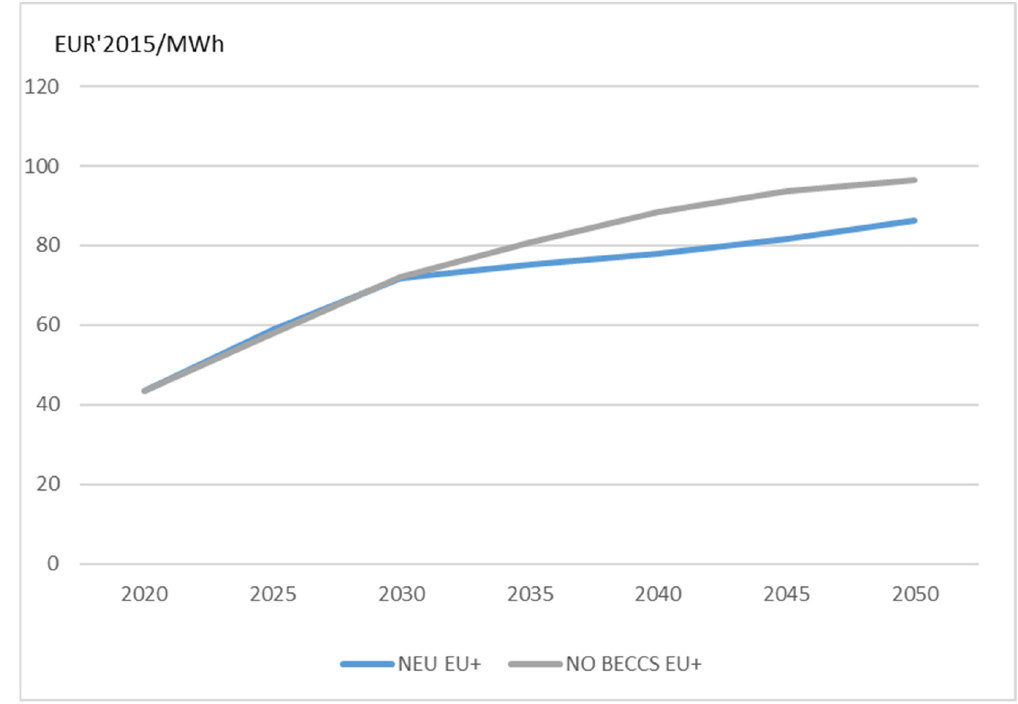
Figure 8. Average electricity generation cost in the EU+ countries (in EUR’2015/MWh). Source: own calculations based on MEESA model results.